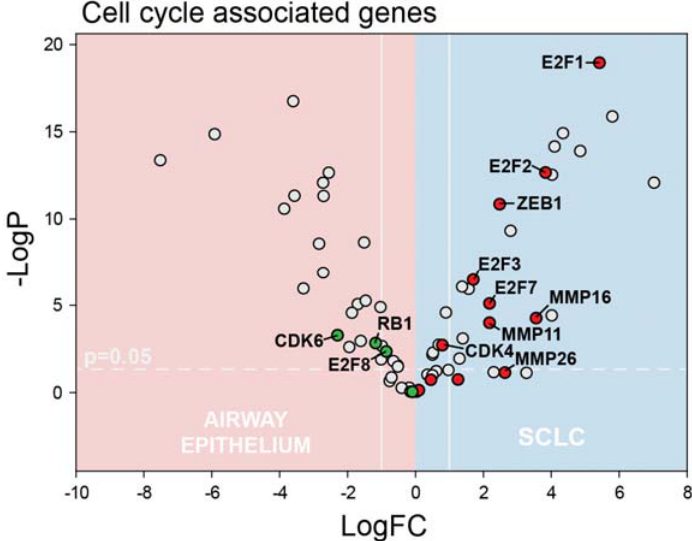
Figure 3. Volcano plot depicting genes involved in cell-cycle regulation. E2F1-3 are transcription factors implicated in upregulating genes important for cell-cycle progression including TYMS and RRM2 and are significantly upregulated in SCLC. In the absence of Rb, E2F-family is involved in upregulating genes important for invasion and metastasis including ZEB1 and MMPs, including MMP-11 , -16 , -26 .